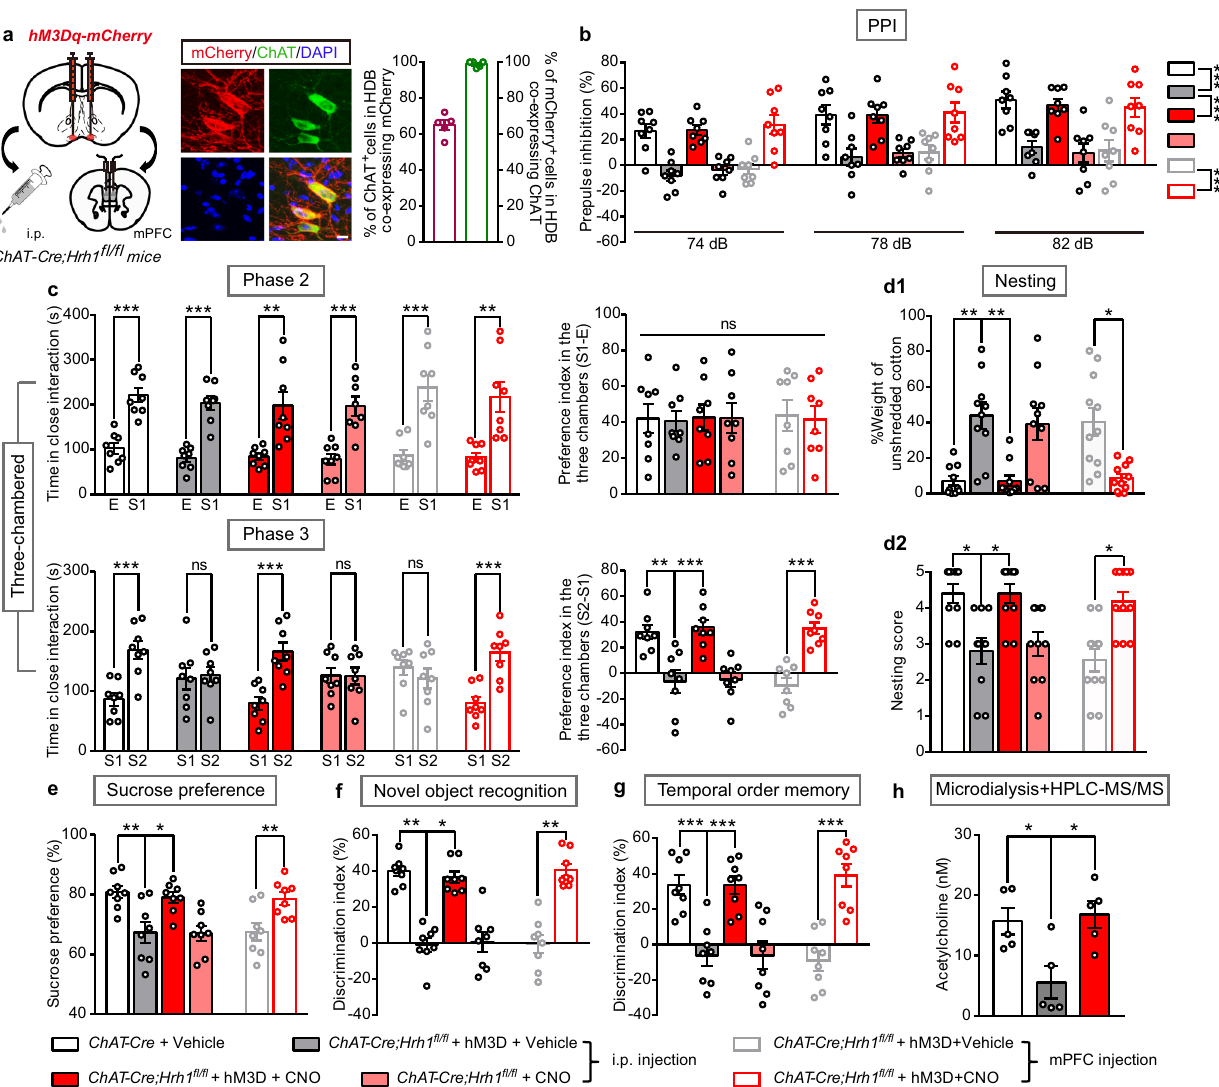
ChAT-Cre;Hrh1 + hM3D+Vehicle hM3D+CNOi.p. injection mPFC injection ChAT-Cre;Hrh1 + ChAT-Cre;Hrh1ChAT-Cre;Hrh1 fl/fl Fig. 5 Chemogenetic activation of cholinergic neurons in the HDB of BF rescues behavioral de fi cits in ChAT-Cre;Hrh1 fl / fl mice. a Schematic diagram of microinjection of AAV-EF1 α -DIO-hM3Dq-mCherry (hM3D-mCherry) in the HDB of BF in ChAT-Cre;Hrh1 fl / fl mice, and representative images of hM3Dq- mCherry expression in HDB ChAT + cholinergic neurons. The percentage of ChAT + cholinergic cells co-expressing mCherry and percentage of mCherry expressed cells co-labeling ChAT were quanti fi ed. Scale bar, 10 μ m, n = 5 mice. b – g Sensorimotor gating, social behavior, hedonic function, and